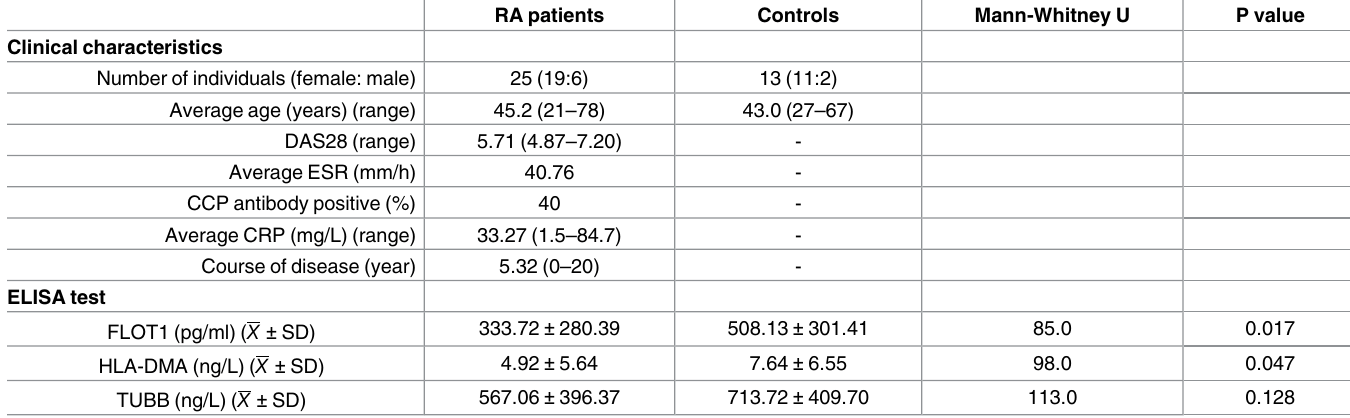
Table 2. Clinical characteristics and ELISA test results of all patients and